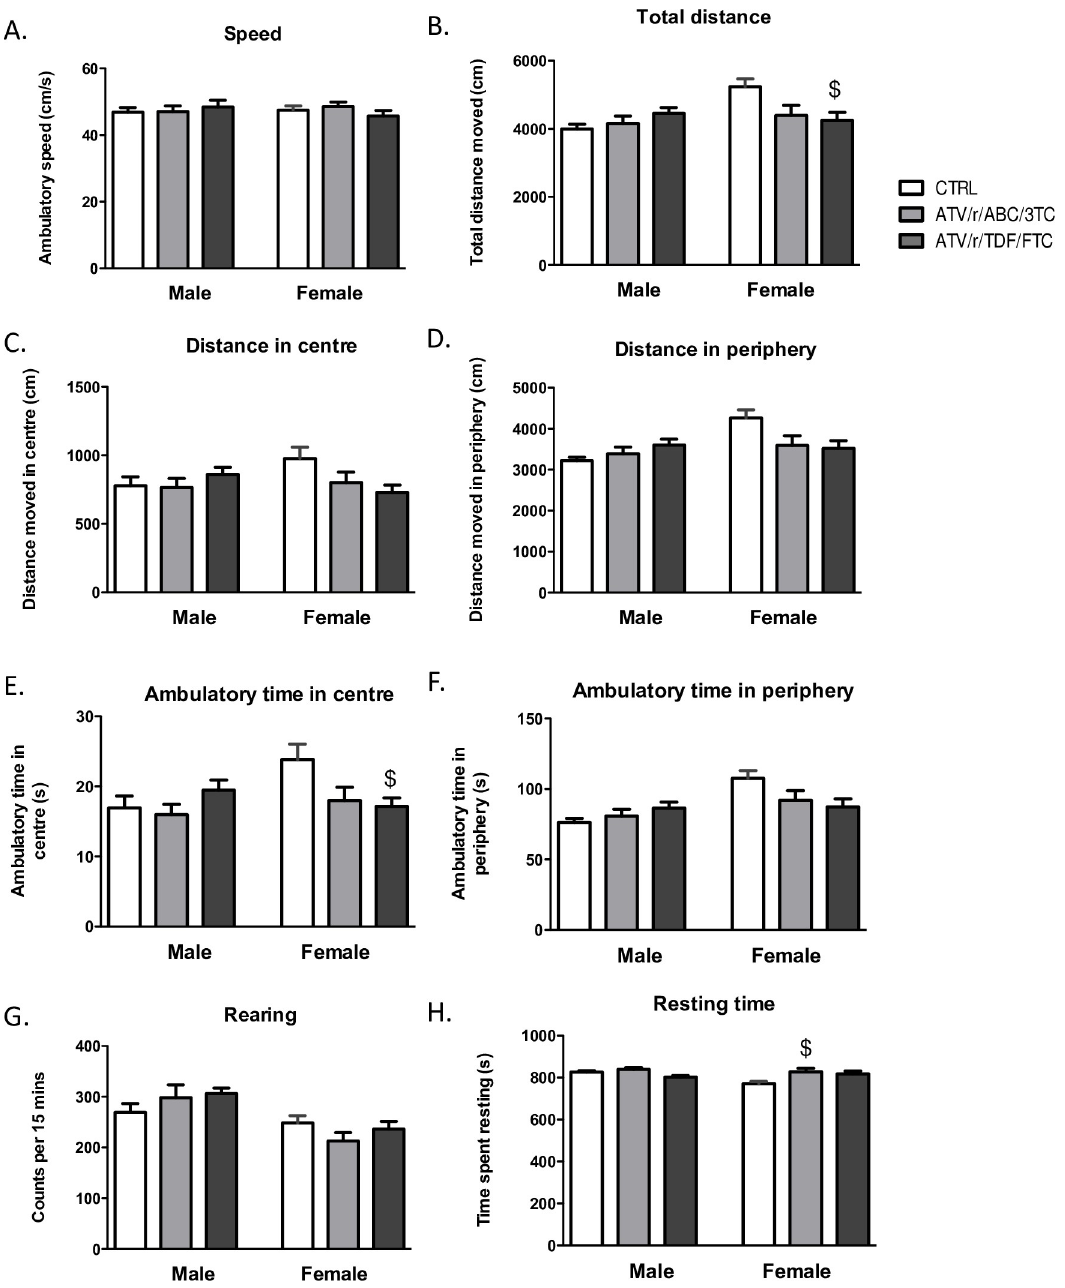
Fig 6. In-utero exposure to ART alters behaviour in the open field test in adulthood. Speed of locomotion (A), total distance moved (B), distance moved in the centre of the arena (C), distance moved in the periphery (D), ambulatory time in the centre of the arena (E), ambulatory time in the periphery (F), rearing time (G), and resting time (H) for male and female mice exposed in-utero to control (CTRL, white bars), ATV/r/ABC/3TC (light grey bars), or ATV/r/TDF/FTC (dark grey bars). Data are mean ± SEM (n = 12– 17 mice/group). One-way ANOVA with Bonferroni multiple comparisons tests was used to examine differences between control and treatment arms for each sex. $ indicates p < 0.05 compared to control females. ATV/r, ritonavir-boosted atazanavir; ABC, abacavir; 3TC, lamivudine; TDF, tenofovir; FTC, emtricitabine; CTRL, control. Mice exposed to ATV/r/ABC/3TC and ATV/r/ TDF/FTC were born with significantly lower birth weight and length compared to controls. These signs of retarded somatic growth,